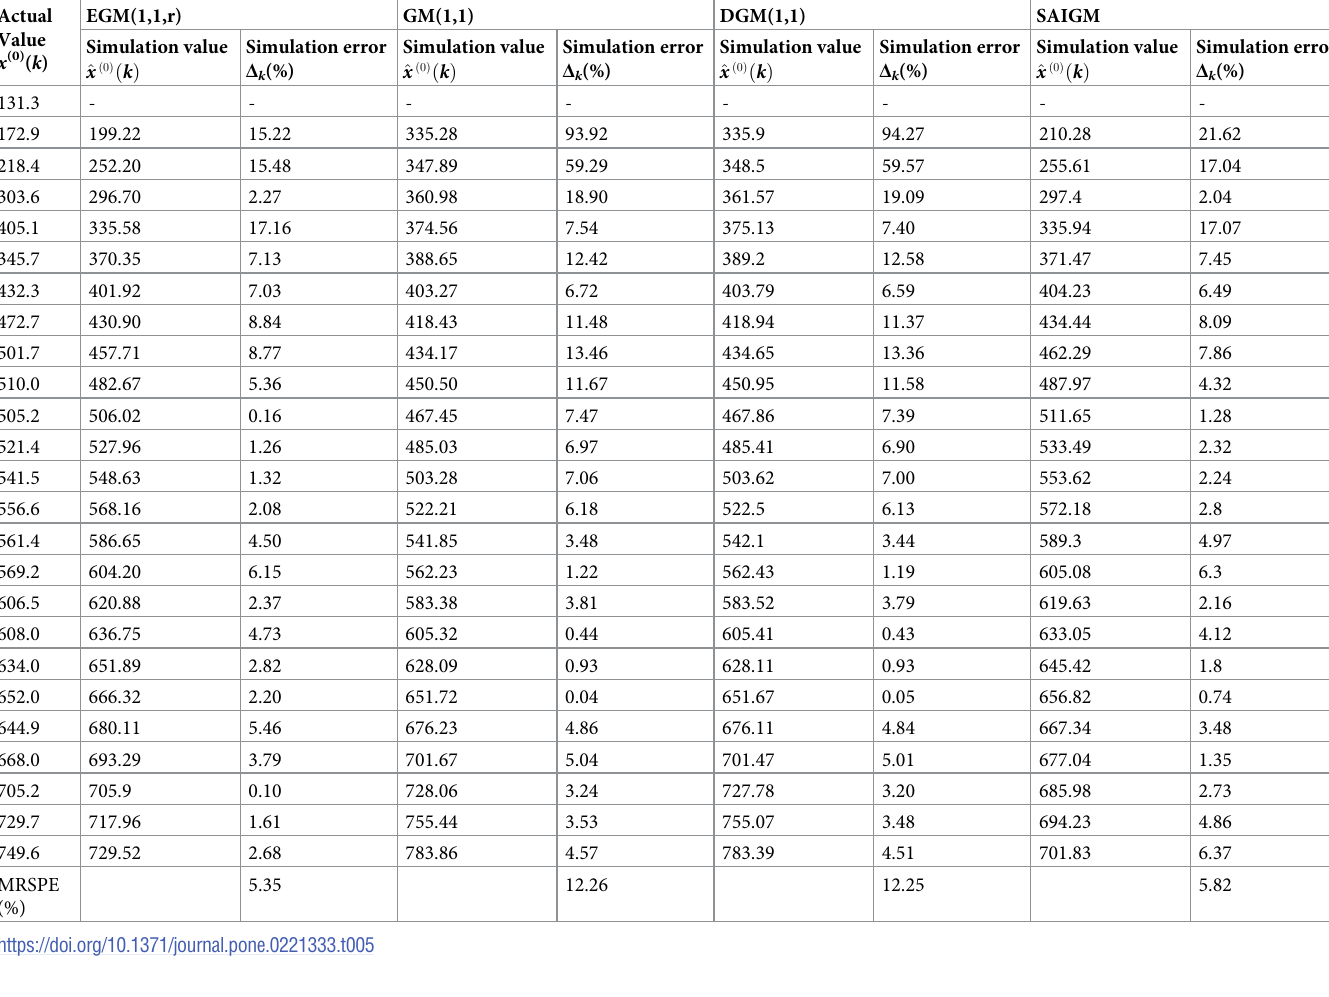
Table 5. Simulation values and MRSPEs of the four models for China’s beef